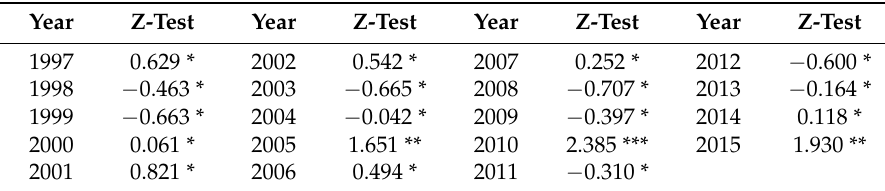
Table 3. Spatial autocorrelation test of the residual.